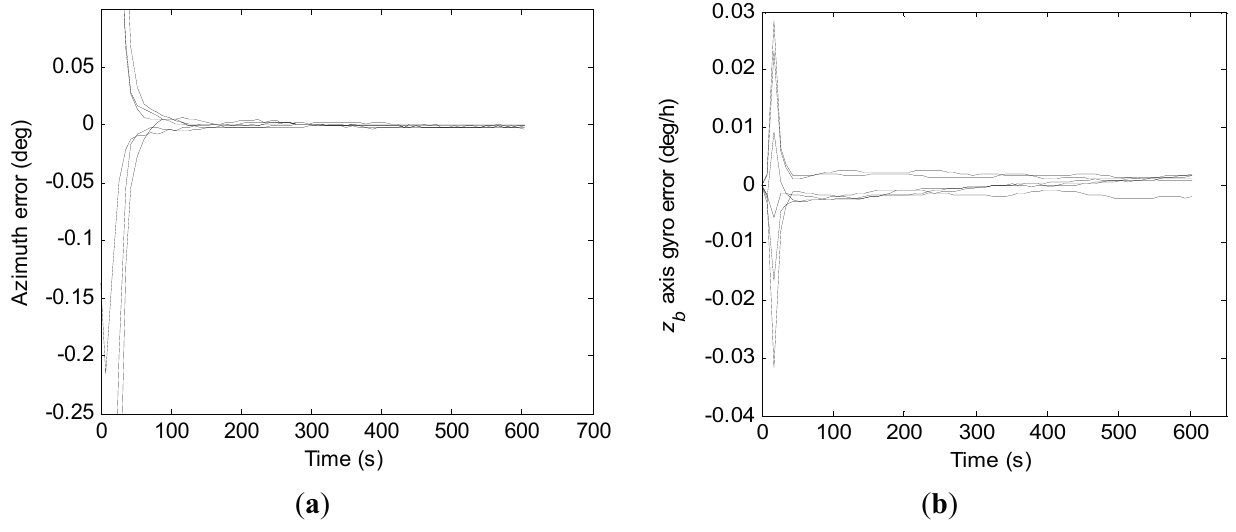
Figure 13. Convergence curves of the azimuth error and the z b axis gyro error within 600 s by the constrained KF scheme. ( a ) Azimuth error; ( b ) z b axis gyro erro. Apparently, as the added measurement quantity has improved the degree of observability of the z b axis gyro bias, the azimuth error and the z b axis gyro error have converged to steady value much faster by the constrained KF scheme than by the conventional KF scheme. Additionally, the 1- σ values of final azimuth error and final z b axis gyro error at 600 s are 4.4 arc-seconds and 0.0014 deg/h from the statistical calculation,